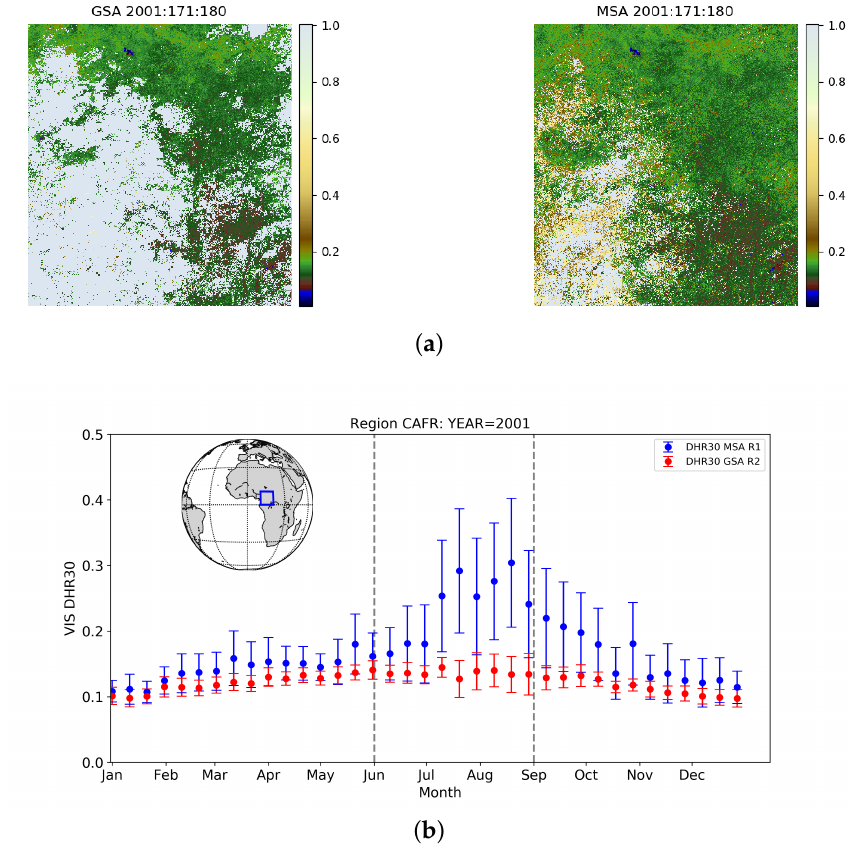
Figure 3. Central Africa (CAFR) region. On the bottom plot ( b ), comparison of VIS DHR30 as re- trieved in the region north of Equator from MSA Release 1 (blue) and GSA Release 2 (red). The season of interest is included between the two dashed vertical lines. On the upper panel ( a ) map comparison between GSA Release 2 (bottom left panel) and MSA Release 1 (bottom right panel) for the period 171–180 (20 to 30 of June)